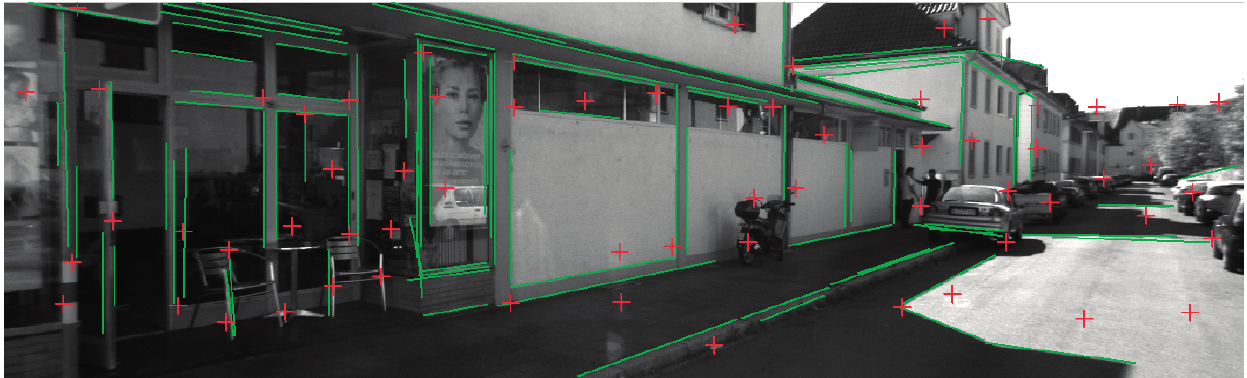
Figure 2. Sample image with extracted point (red) and line (green) features.